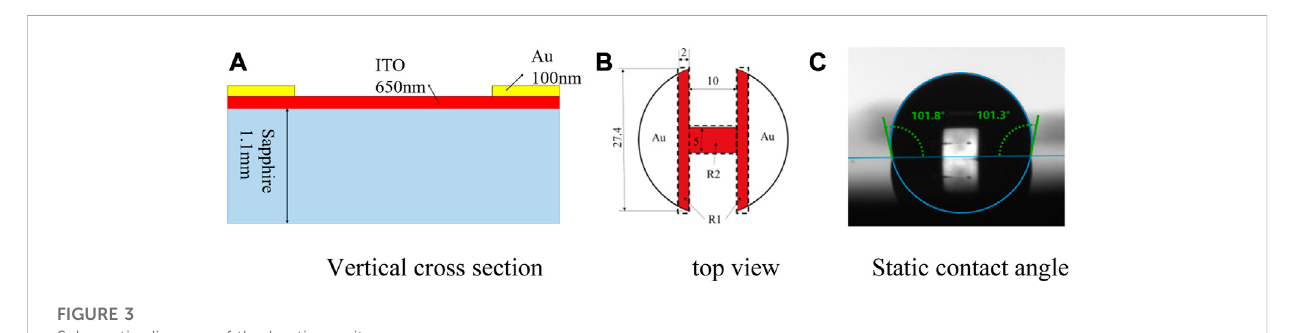
FIGURE 3 Schematic diagram of the heating